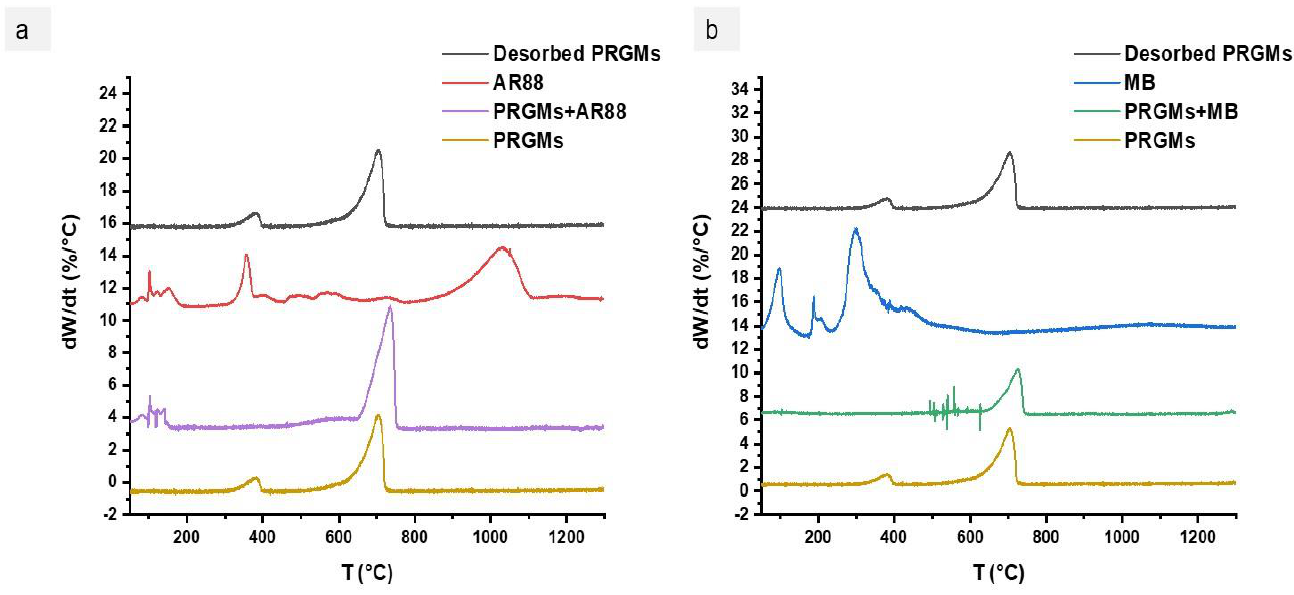
Figure 10. A DTG graph of PRGMs with ( a ) AR88 and ( b ) MB dye before and after dye adsorption and desorption.